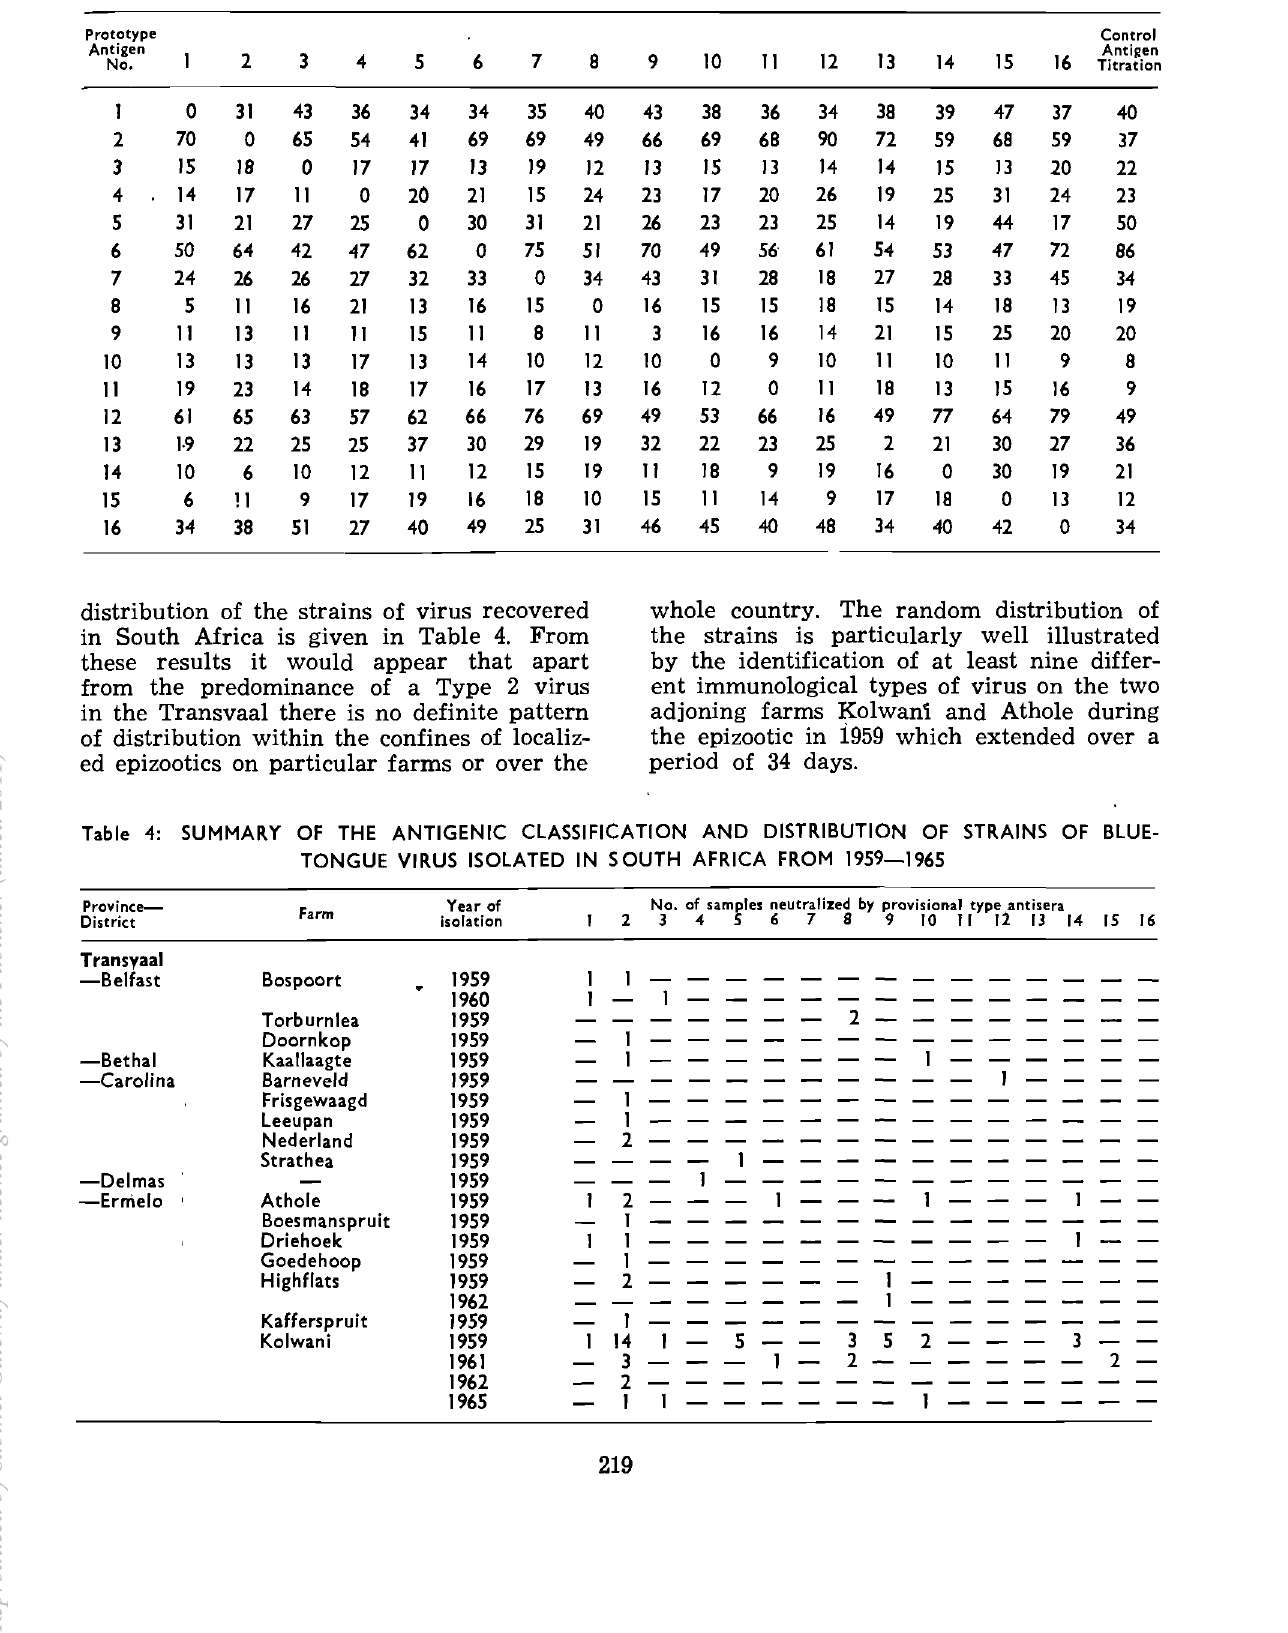
Table 3: CROSS-NEUTRALIZATION BETWEEN PLAQUE PURIFIED STRAINS BY PLAQUE INHIBITION TESTS Prototype Antigen No.